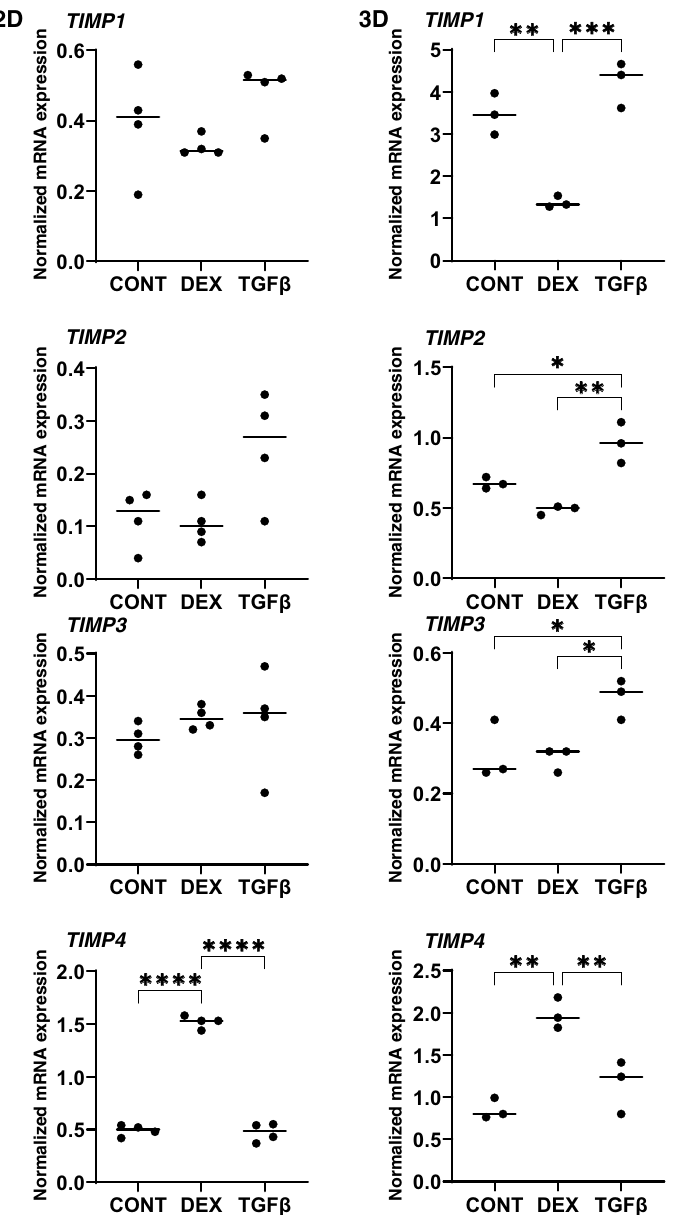
Figure 8. mRNA expression of TIMPS and MMPs in HTM 2D cells and 3D spheroids. Among the experimental groups treated with or without 250 nM DEX or 5 ng/ml TGFβ2, HTM 2D cells and 3D spheroids at Day 6 were subjected to qPCR analysis to estimate the expression of mRNA in TIMP 1–4 (panel A ), and MMP2,9 and 14 (panel B ). All experiments were performed in duplicate using fresh preparations (n = 3). Data are presented as the arithmetic mean ± standard error of the mean (SEM). * P < 0.05; ** P < 0.01; *** P < 0.005 (ANOVA followed by a Tukey’s multiple comparison